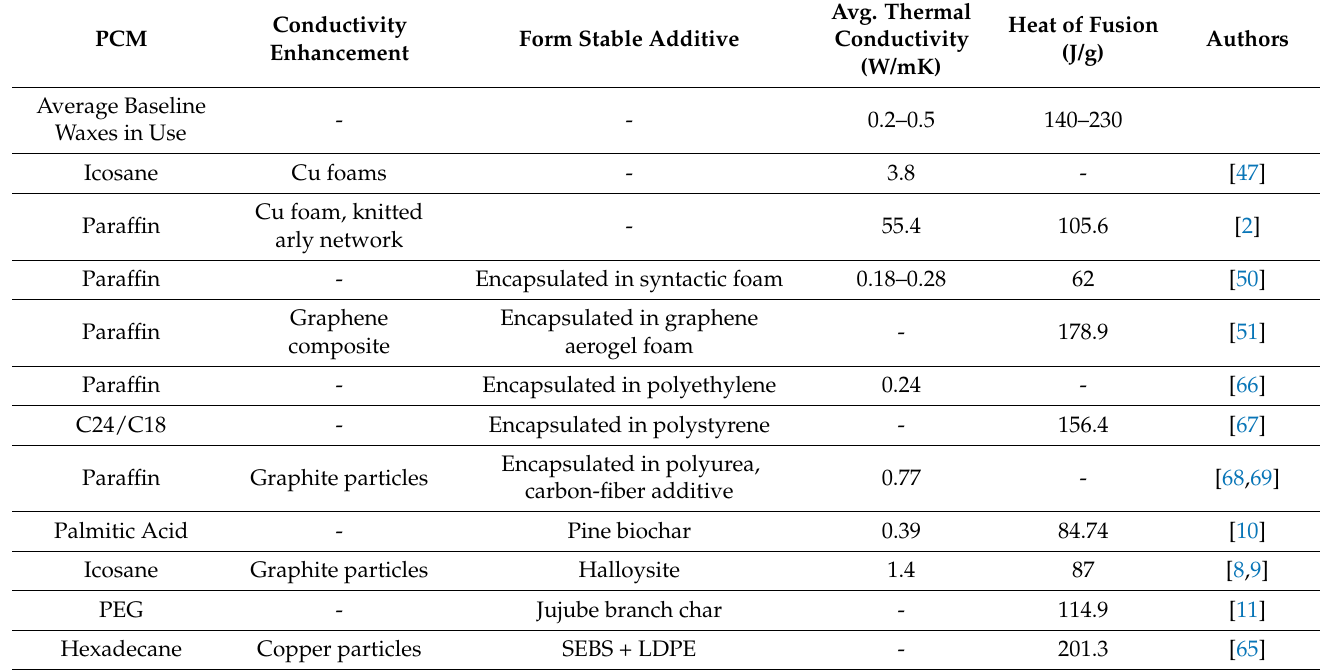
Table 1. Summary of reported average values from different PCM studies